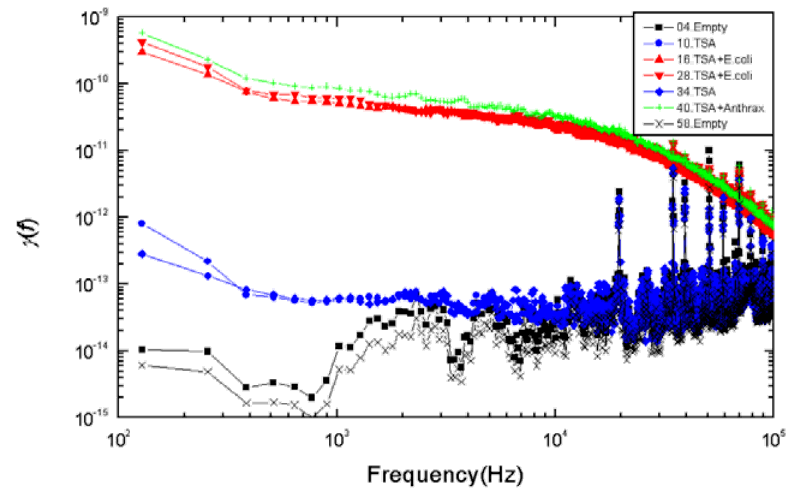
Figure 5. Normalized power density spectra of the resistance fluctuations of the sensor SP32 measured in the sampling-and-hold [8,10] working mode. Each sample had one million bacteria. The alias " Anthrax " stands for Anthrax surrogate Bacillus subtilis .